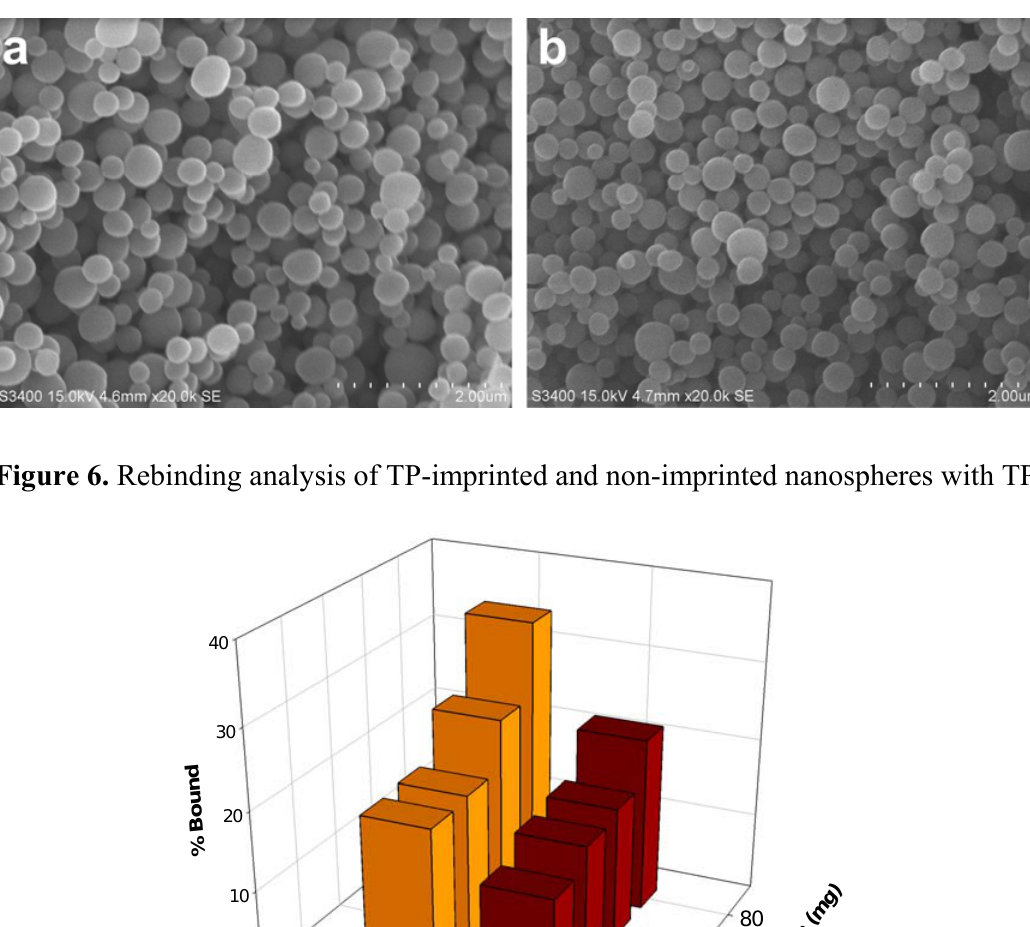
Figure 5. SEM micrograph of TP-imprinted nanospheres (a) and non-imprinted nanospheres (b).